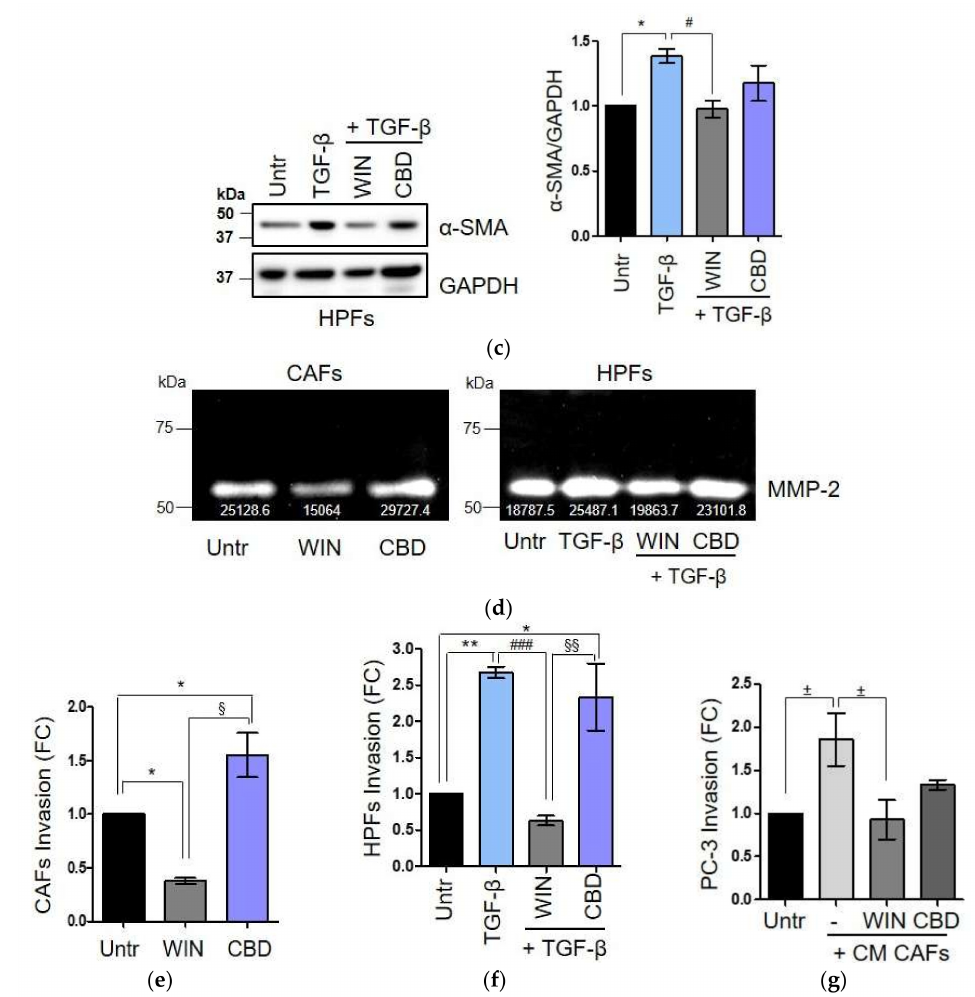
Figure 3. WIN 55-212.2 mesylate a ff ects CAFs’ reactivity and impairs TGF- β -mediated activation of HPFs. ( a ) HPFs and CAFs were treated with increasing concentrations of WIN 55-212.2 mesylate and CBD for 24 h; then, cells survival was determined by crystal violet staining. Data represent means ± SEMs of three independent biological replicates. p-values were determined by Student’s t test. * p < 0.05, ** p < 0.01, *** p < 0.001 WIN versus control (Untr); ## p < 0.01, ### p < 0.001 CBD versus Untr. We choose cannabinoid concentration at 2.5 µ M to perform all functional assay. ( b , c ) Western blot analysis and quantitative measurement of α -SMA expression in CAFs (upper) and HPFs activated in vitro by TGF- β 10 ng / mL (lower) treated with WIN 55-212.2 mesylate and CBD 2.5 µ M for 24 h. Data represent means ± SEMs of three independent biological replicates performed on fibroblasts isolated from two di ff erent explants. Relative α -SMA expressions were normalized respect to GAPDH and represented as FC versus control Untr. p-values were calculated by one-way ANOVA followed by Bonferroni’s multiple comparison test. * p < 0.05 versus Untr; # p < 0.05 versus TGF- β . ( d ) Gelatin zymography of conditioned media (CM) 10 fold concentrated from CAFs (left) and HPFs (right) treated like above. The white numbers in bolt indicate quantification of two independent biological replicates. ( e , f ) 1 × 10 5 CAFs (left) or HPFs activated in vitro by TGF- β 10 ng / mL (right) were treated with cannabinoids 2.5 µ M and allowed to invade toward complete medium (10% FBS) for 24 h. Data represent means ± SEMs of three biological replicates. One-way ANOVA, Bonferroni’s corrected. * p < 0.05, ** p < 0.01 versus Untr; § p < 0.05, §§ p < 0.01 versus WIN; ### p < 0.001 versus TGF- β . ( g ) 3 × 10 4 PC-3 cells were incubated with CM from CAFs treated or not with cannabinoids 2.5 µ M and allowed to invade toward complete medium. Starved cells have been used as negative control (Untr). Results express means ± SEMs of three independent biological replicates performed with CM from two di ff erent CAFs. One-way ANOVA, Dunnet’s corrected. ± p < 0.05 versus CM